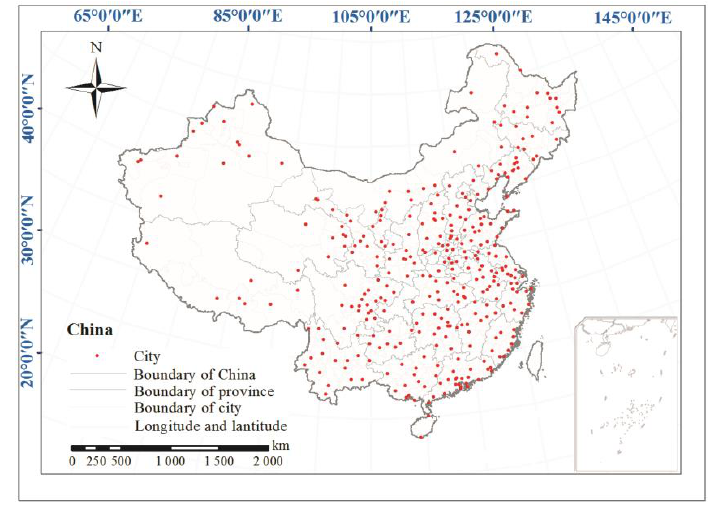
Figure 1. Locations of the 336 Chinese cities with available and sufficient data.